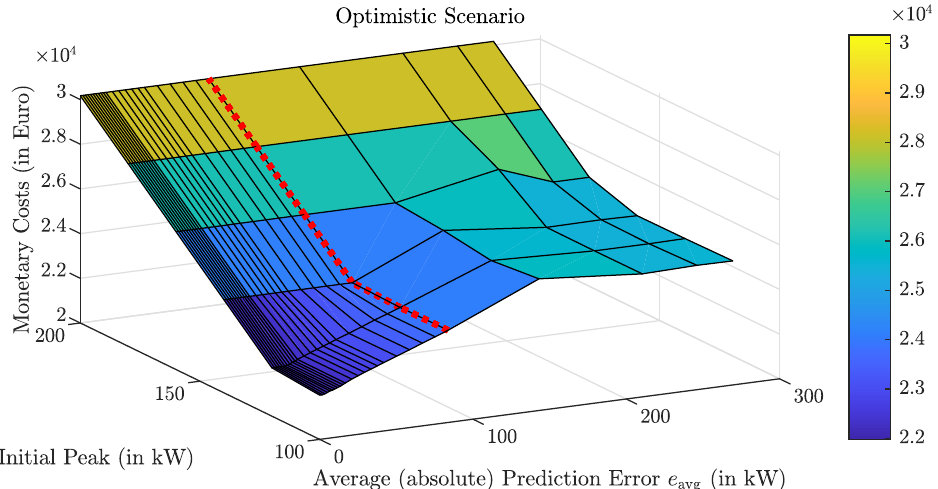
Figure 6. Monetary costs for different prediction errors and initial peaks in the optimistic scenario. Peak costs of the initial peaks are included. The red dotted line shows the error level with real predictions ( e avg ( s err = 1 ) =